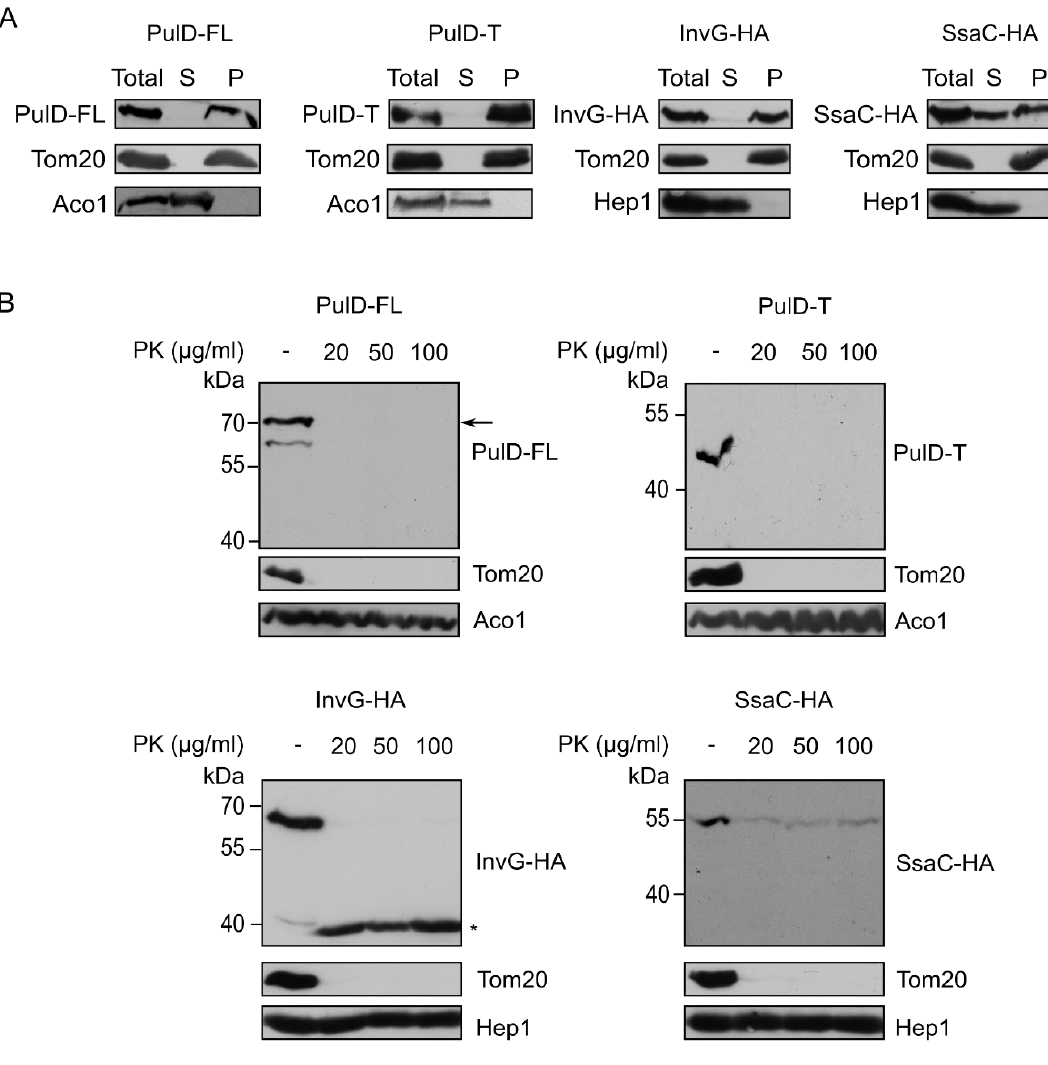
FIGURE 3: Secretins are embedded in the mitochondrial OM and exposed to the cytosol. (A) Mitochondria isolated from wild type cells ex- pressing the indicated secretins were either left untreated (Total) or subjected to alkaline extraction. The supernatant (S) and pellet (P) frac- tions were analysed by SDS – PAGE and immunodecoration with antibodies against the indicated proteins. Tom20, an integral OM protein; Aco1 and Hep1, soluble matrix protein. (B) Mitochondria isolated from wild type cells expressing the indicated secretins were treated with increas- ing amounts of proteinase K (PK). Samples were analysed by SDS – PAGE and immunodecoration with antibodies against PulD, HA-tag and the indicated mitochondrial proteins. Full-length PulD is indicated with an arrow whereas a proteolytic fragment of InvG with an